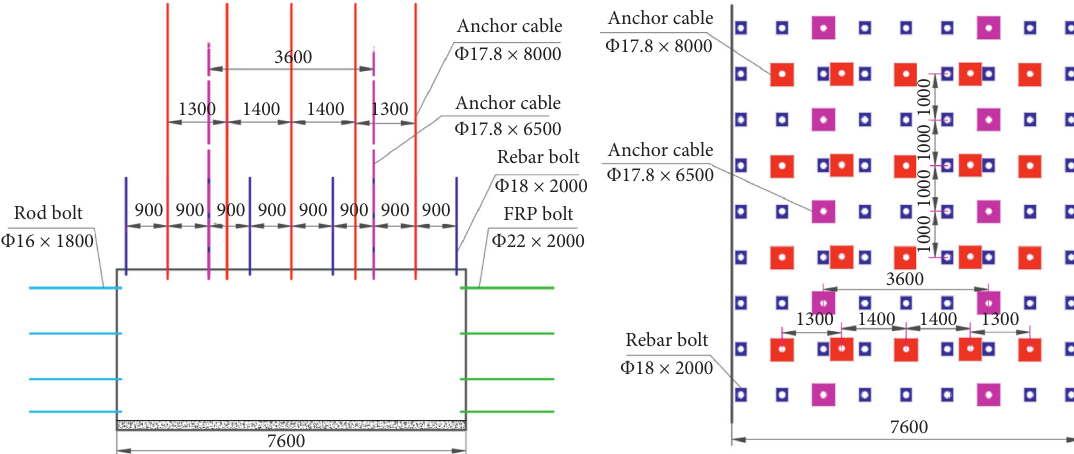
Figure 14: Design support scheme of 31207 open-off